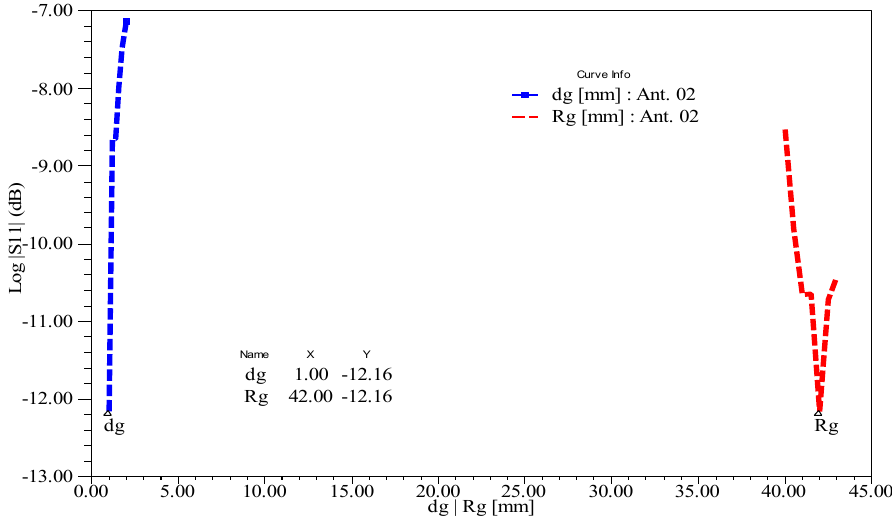
Figure 8. Reflection coefficient of Slot antenna 2 at 2450 MHz versus dg and Rg (mm).